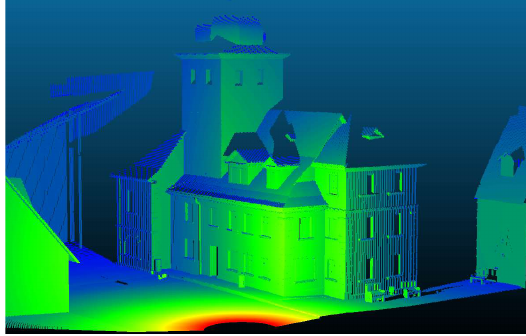
Figure 2: Example of a point cloud of the university office building generated by the VirScan3D simulator.